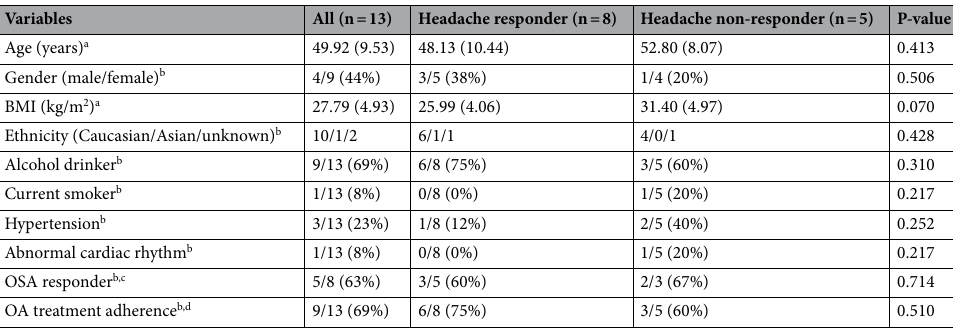
Table 1. Baseline demographic and clinical characteristics of study groups. BMI body mass index, OSA obstructive sleep apnea, OA oral appliance. a Differences between groups were tested with t-test: Mean (SD). b Differences between groups were tested with Chi-square test: number of male or positive participants/total number of participants (percentage of male or positive participants). c Decrease in AHI > 50% compared to baseline AHI. Results given as number of OSA responders/total number of patients (percentage of OSA responders). d Using the appliance for > 50% of the night on ≥ 4 nights a week. Results given as number of OA adherent patients/total number of patients (percentage of OA adherent